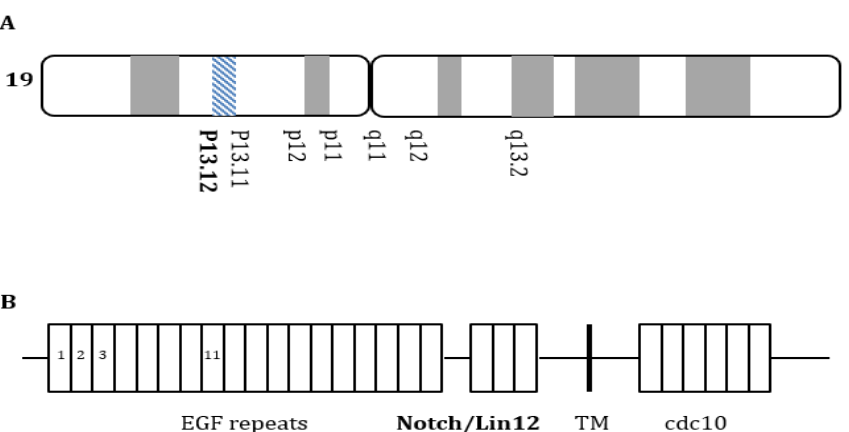
Figure 1. NOTCH3 gene mutations. ( A ) NOTCH3 gene located on chromosome 19p13.12; ( B ) NOTCH3 gene mutations are located within the extracellular domain that encodes the epidermal growth factor-like repeats, three Lin-NOTCH repeats, and one transmembrane region.